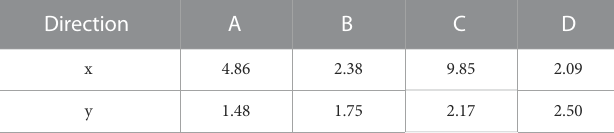
TABLE 9 Reduction of residual stress with ultrasonic frequency from 20 kHz to 28 kHz (%).